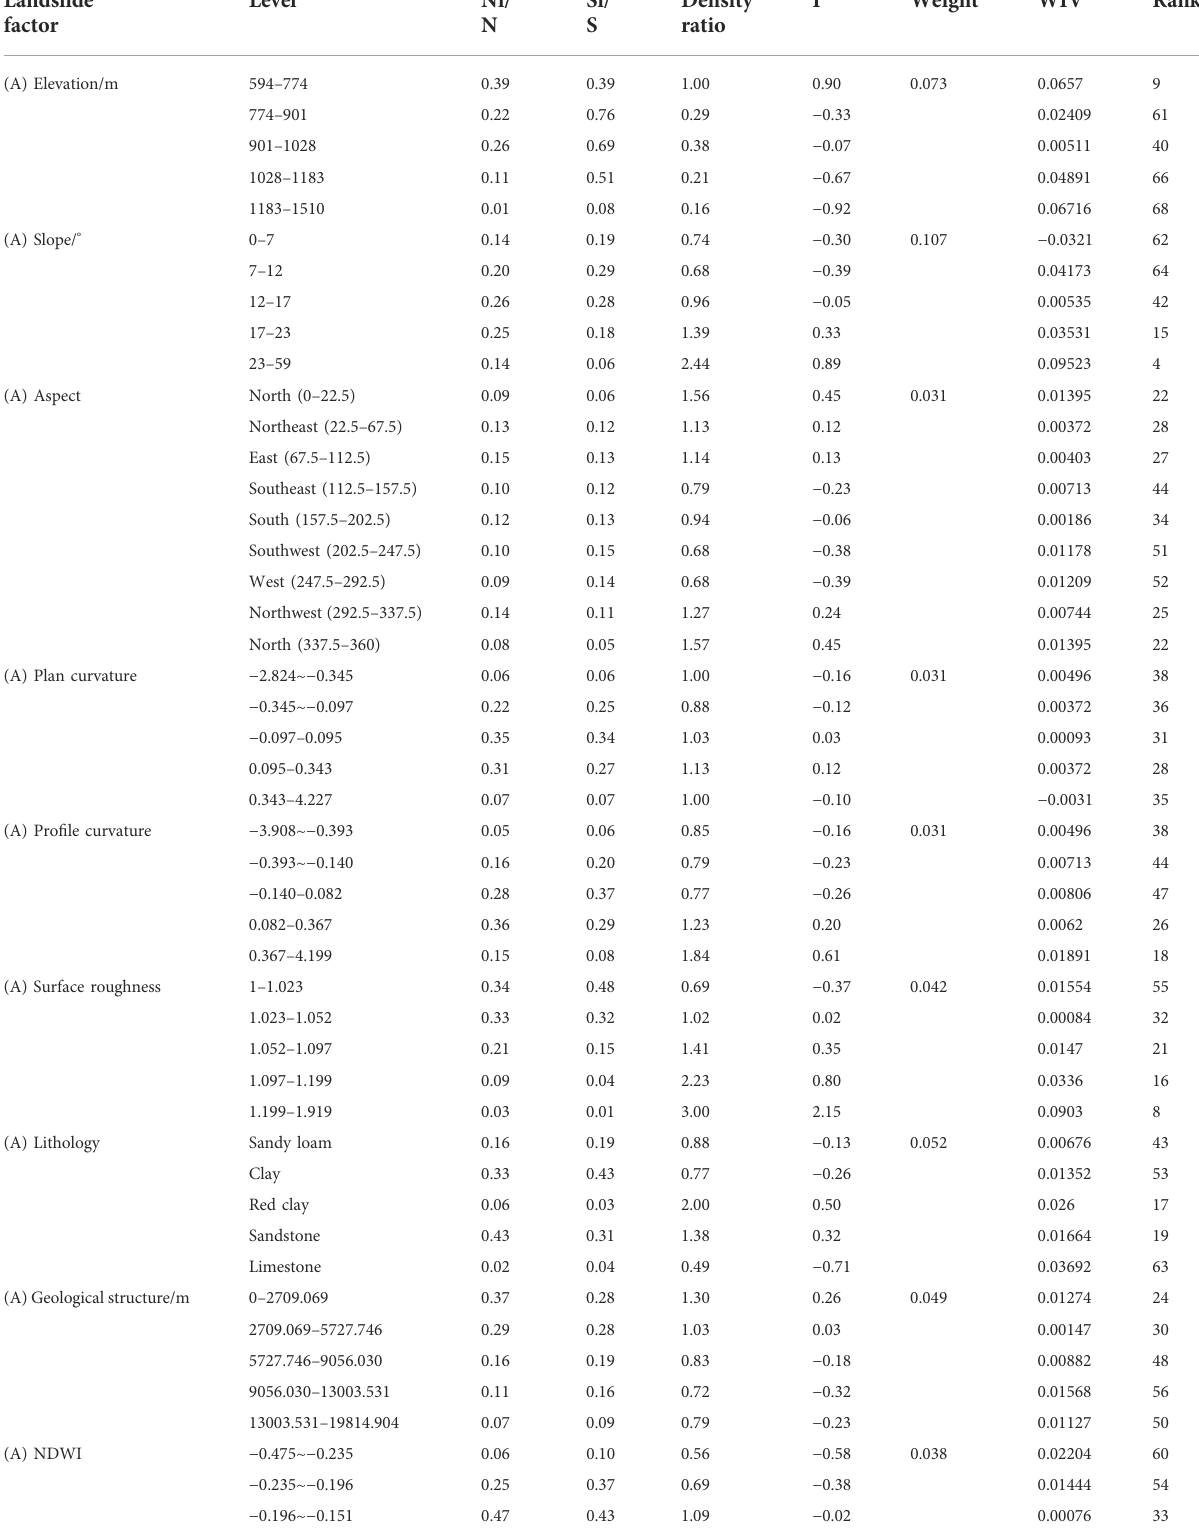
TABLE 4 Calculation of the IVs of the landslide in fl uencing factors. Landslide